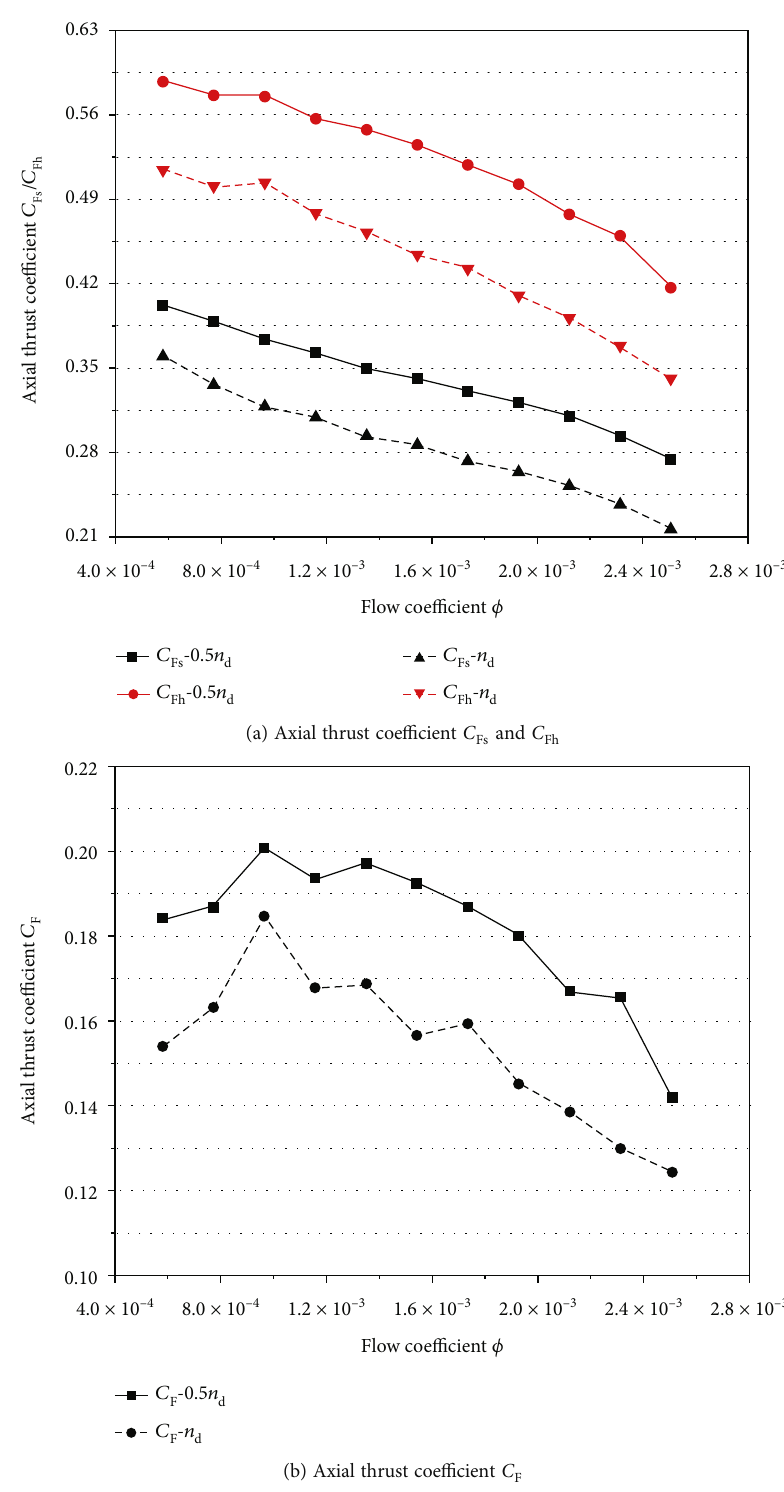
Figure 9: Comparison of the axial thrusts under di ff erent rotational